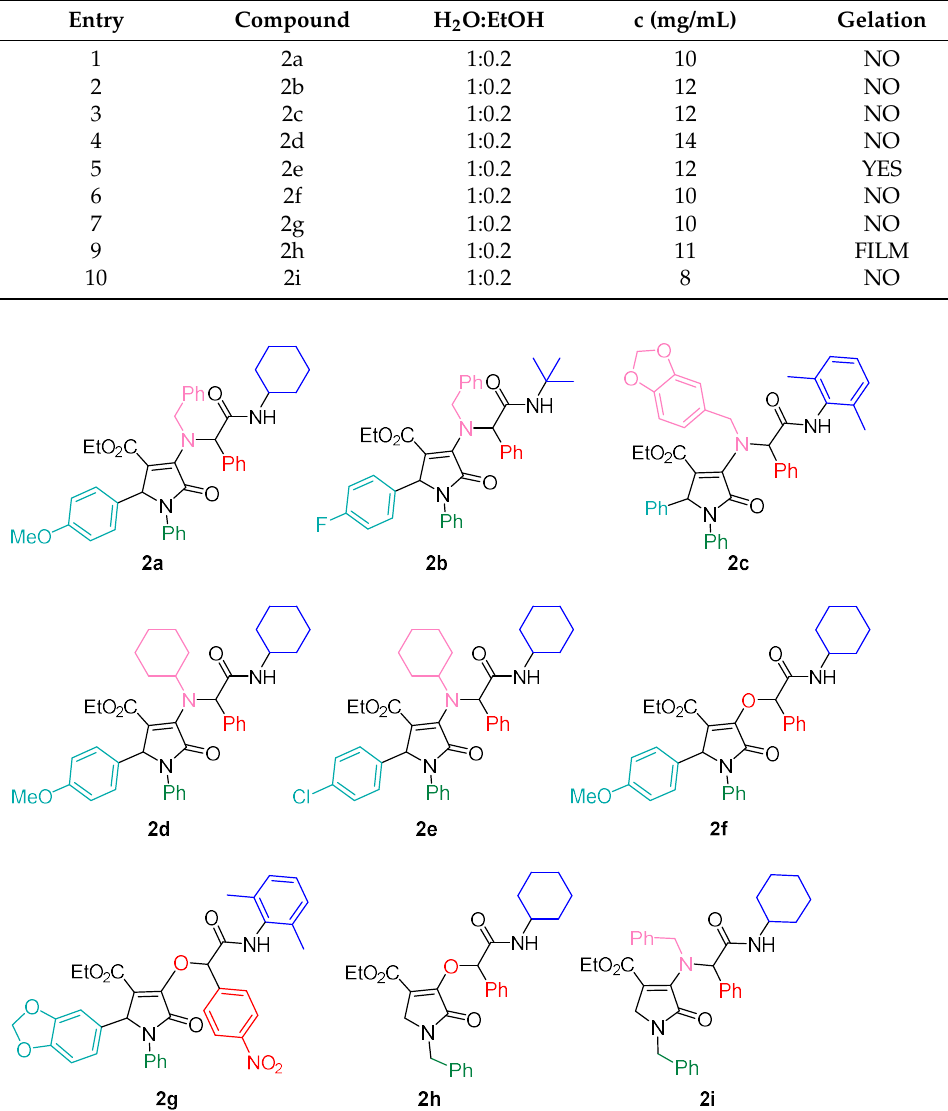
Table 2. Gelation test of peptidomimetics 2a–i.